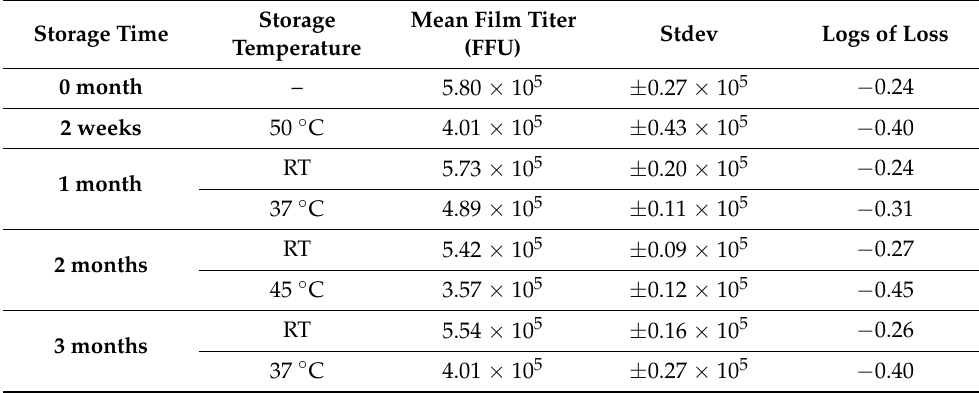
Table 3. Stability of PBV RRV-TV dissolvable